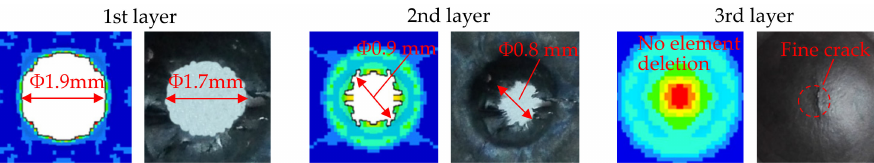
Figure 13. Comparison of experimental and simulated force-displacement curve and numerically prediction failure evolution of anode in multilayered LEMs during local indentation.